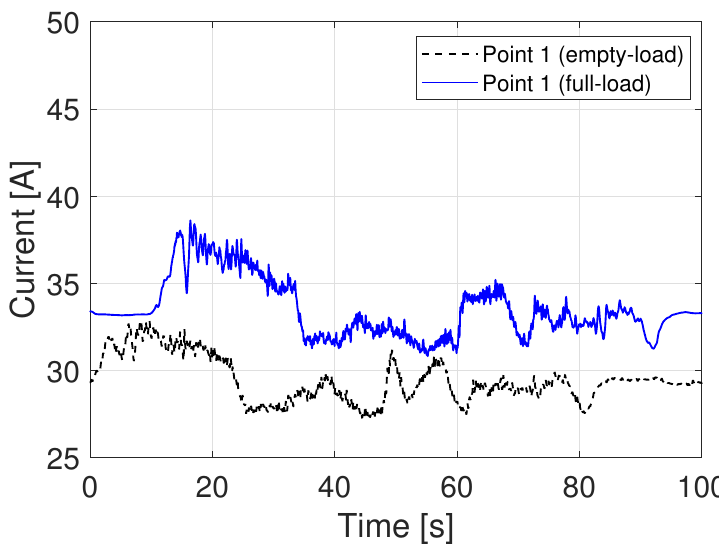
Figure 7. Experimental data of current value (the point 1 of the suspension module 101).